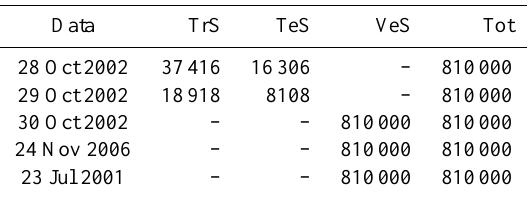
Table 2. The Training, Test and Validations sets extracted from the data, for the ash detection